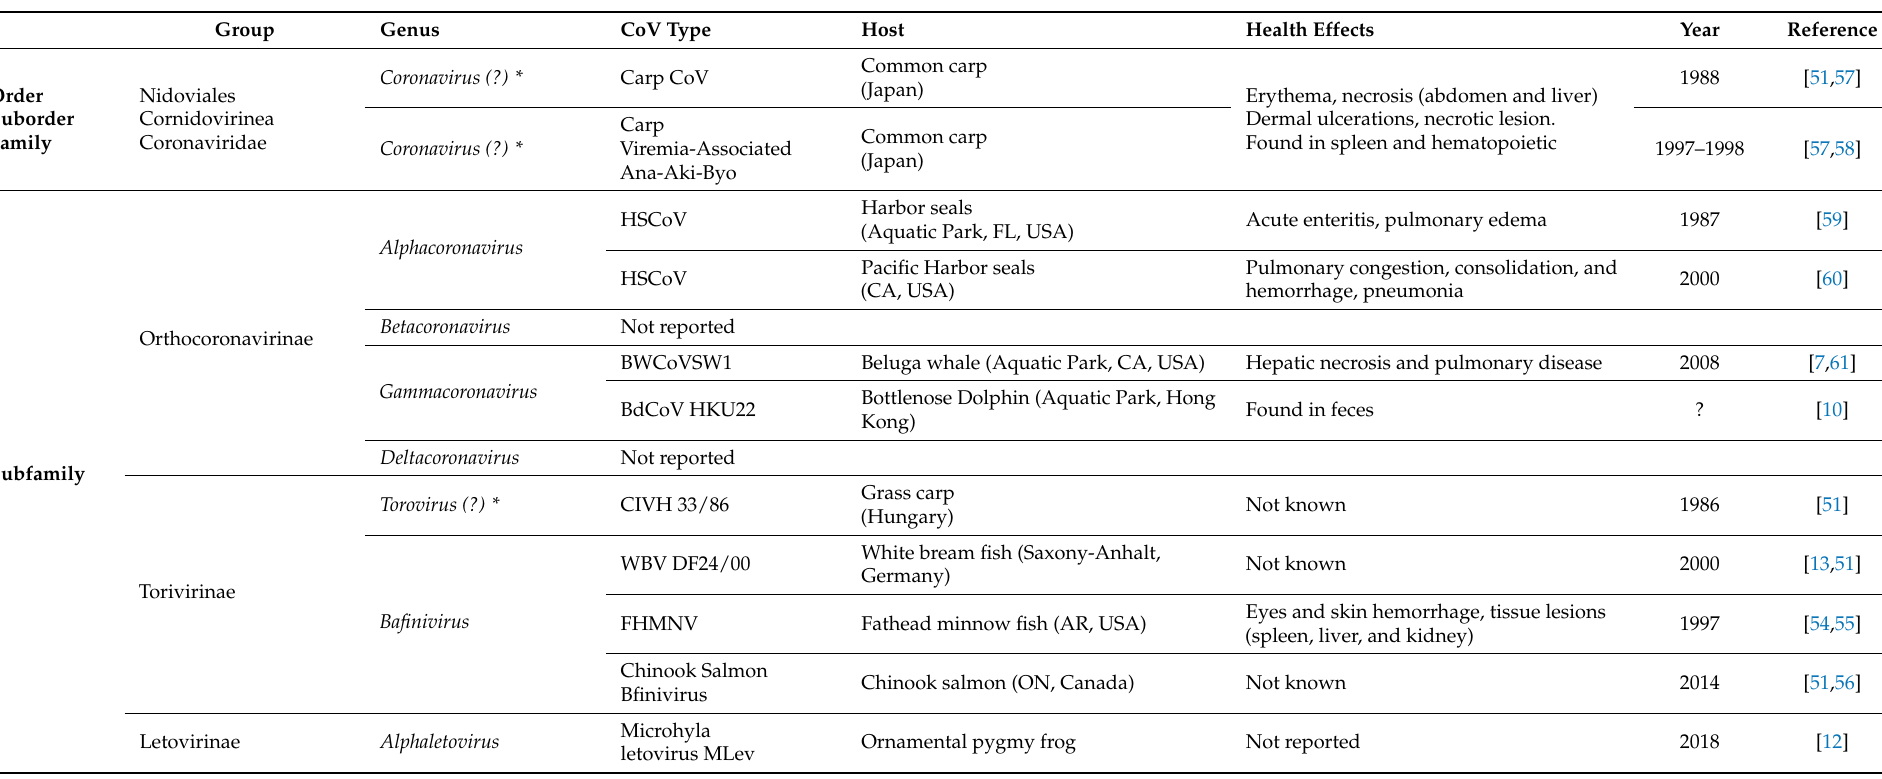
Table 1. Coronavirus found in aquatic organisms. Taxonomical groups, according to de Groot et al. [7] and Kasmi et al.